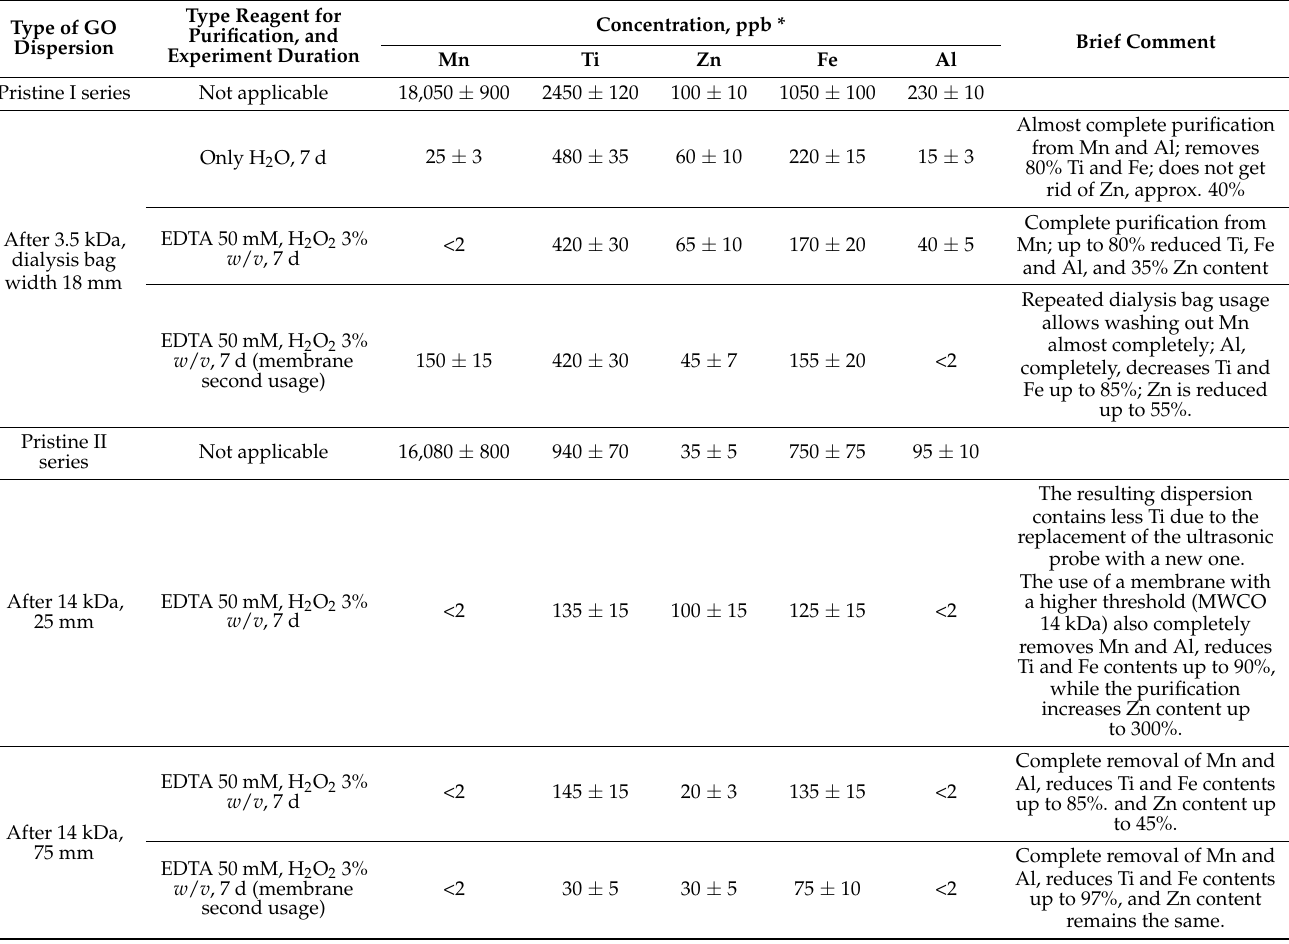
Table 1. Dialysis efficiency of transition metal content purification of GO dispersions estimated by ICP-AES ( n = 3, p =